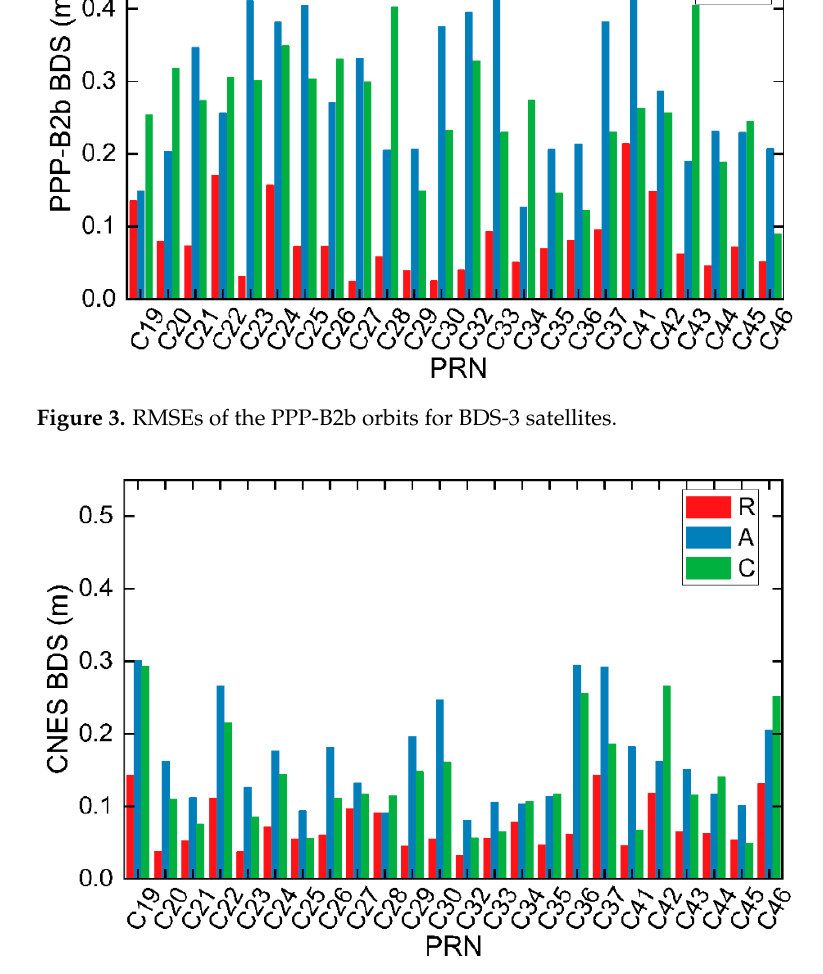
Figure 5. RMSEs of the PPP-B2b orbits for GPS satellites. Figure 6. RMSEs of the CNES orbits for GPS satellites. To further evaluate the precision of the PPP-B2b and CNES orbits, their average RMSEs were calculated, as presented in Table 4. For the BDS-3, the RMSEs are 0.082, 0.288, and 0.262 m in the R/A/C directions for the PPP-B2b real-time orbit, and 0.073, 0.066, and 0.138 m for the CNES real-time orbit. For the GPS, the RMSEs are 0.093, 0.386, and 0.278 m in the R/A/C directions for the PPP-B2b real-time orbit, and 0.034, 0.052, and 0.034 m for the CNES real-time orbit. Furthermore, the accuracy of the PPP-B2b orbit in the R di- rection is within 0.1 m, which is slightly lower than that of the CNES real-time orbit.